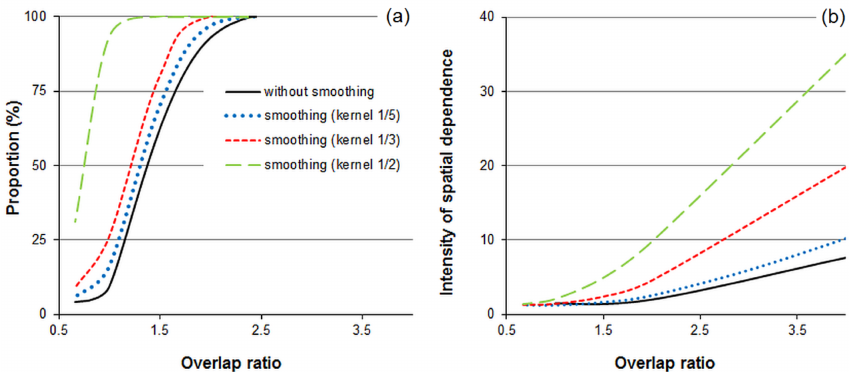
Figure 9. Effect of the overlap ratio (window diameter to moving distance) on the proportion of positive identifications ( a ) and intensities of the spatial dependence between the phase assignments obtained from the moving window procedure ( b ). For overlap ratios ≤ 1, the tree collectives within the neighboring window segments share no common trees. The spatial dependence was determined for the original (not smoothed) and filtered (majority filter, kernel size 1/5, 1/3, or 1/2 of the window diameter) raster models of phase distributions based on 100 simulations of random tree